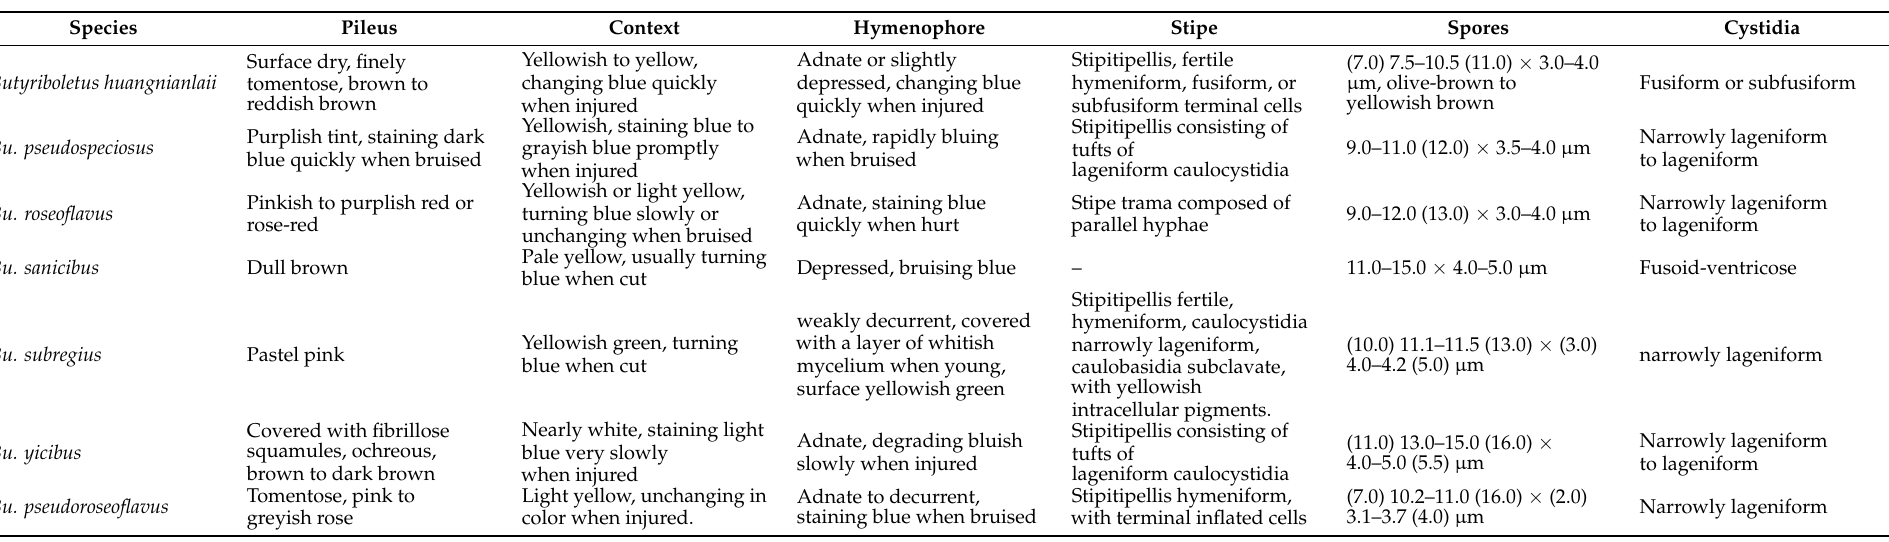
Table 2. Morphological comparisons of Butyriboletus pseudoroseoflavus sp. nov. and Butyriboletus subregius sp. nov. with other Butyriboletus spp. reported in